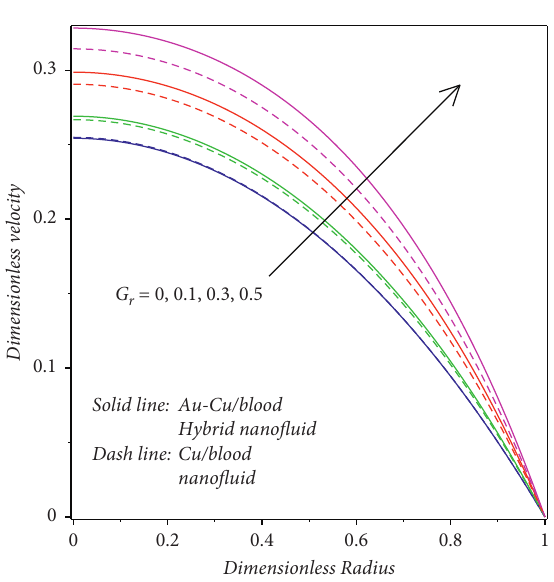
Figure 9: Behaviour of G